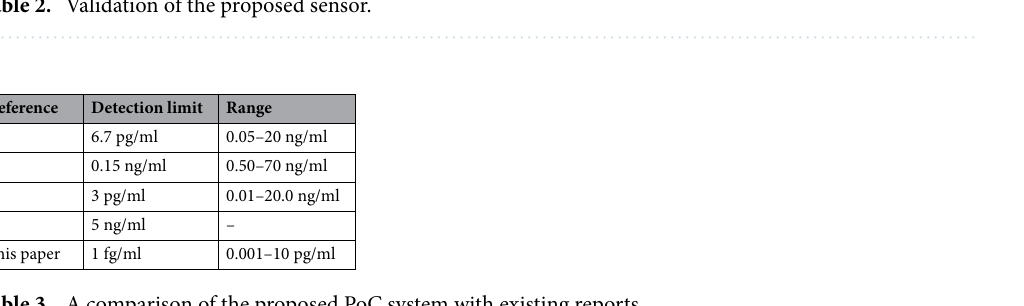
Table 2. Validation of the proposed sensor.